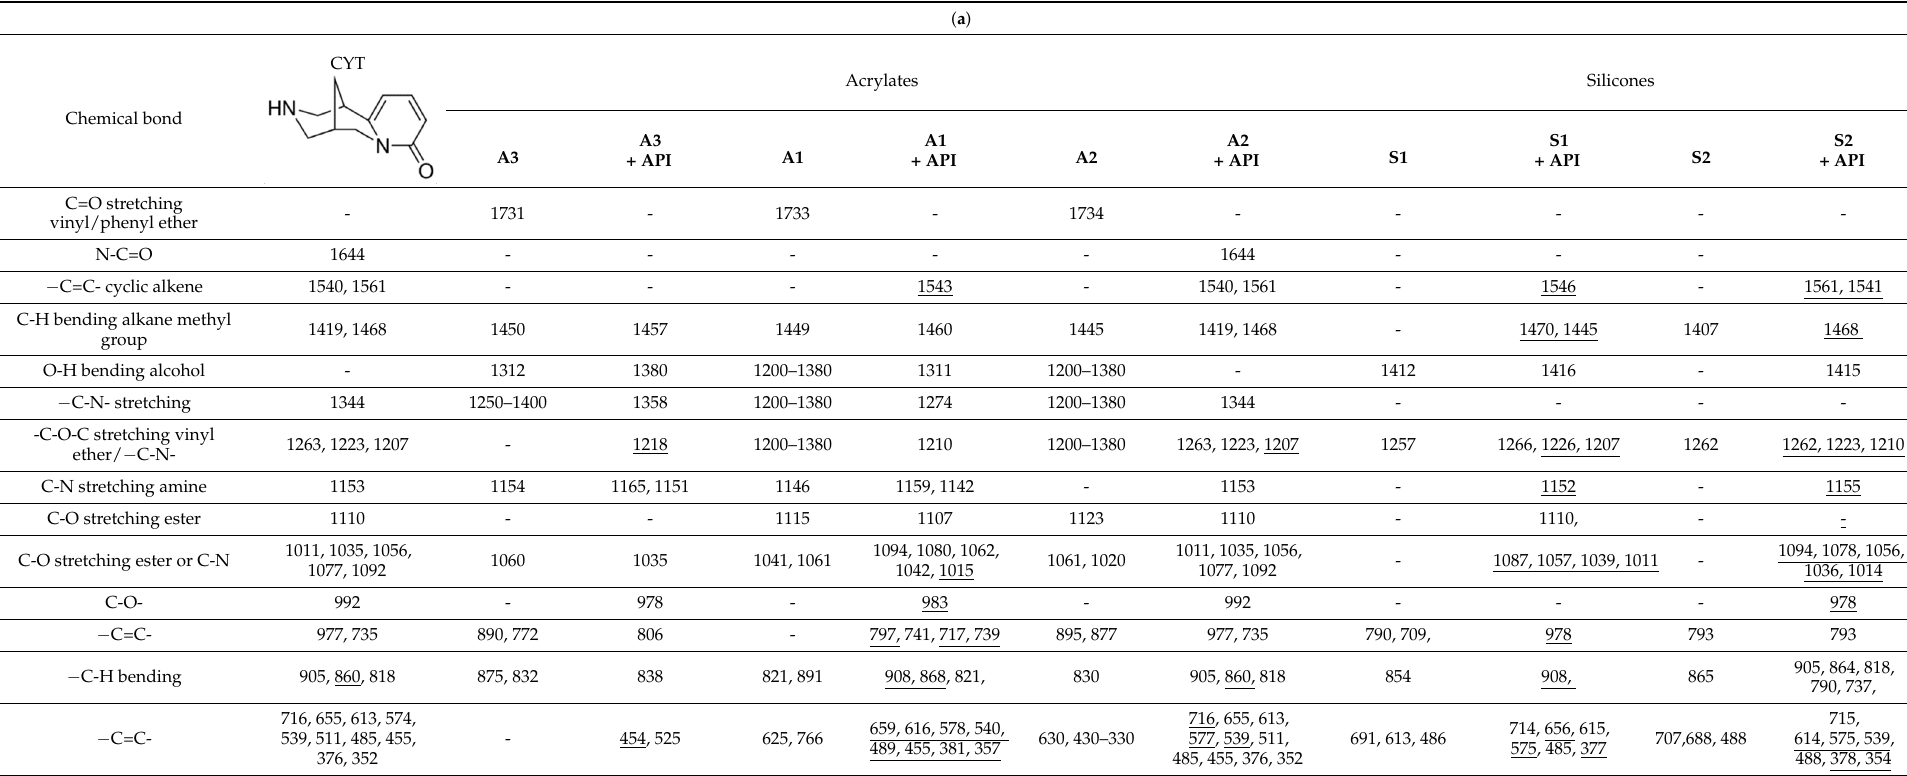
Table 4. Raman identification of IND (b), CYT (a) and TST (c) in the polymeric matrices (peaks or wavenumber ranges underlined are characteristic for API identification in respective patches and not present in placebo polymer film)